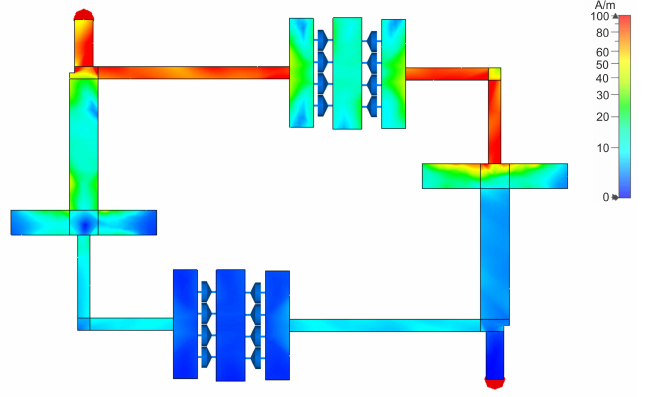
Figure 17. Exemplary current distribution at the transmission zero frequency (665 MHz) of the